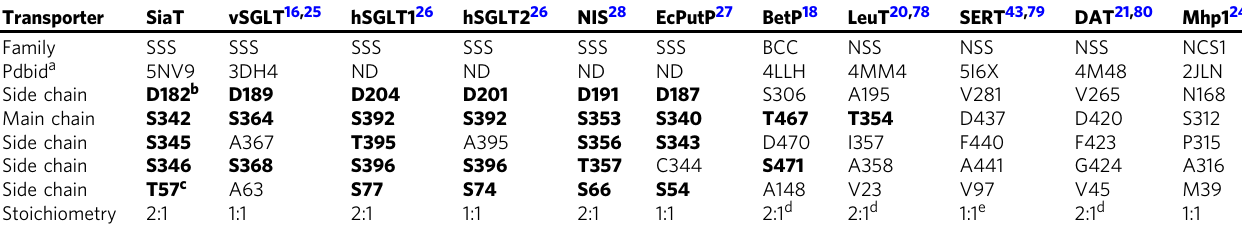
Table 2 Sodium to substrate stoichiometry and residues of the sodium Na3 site